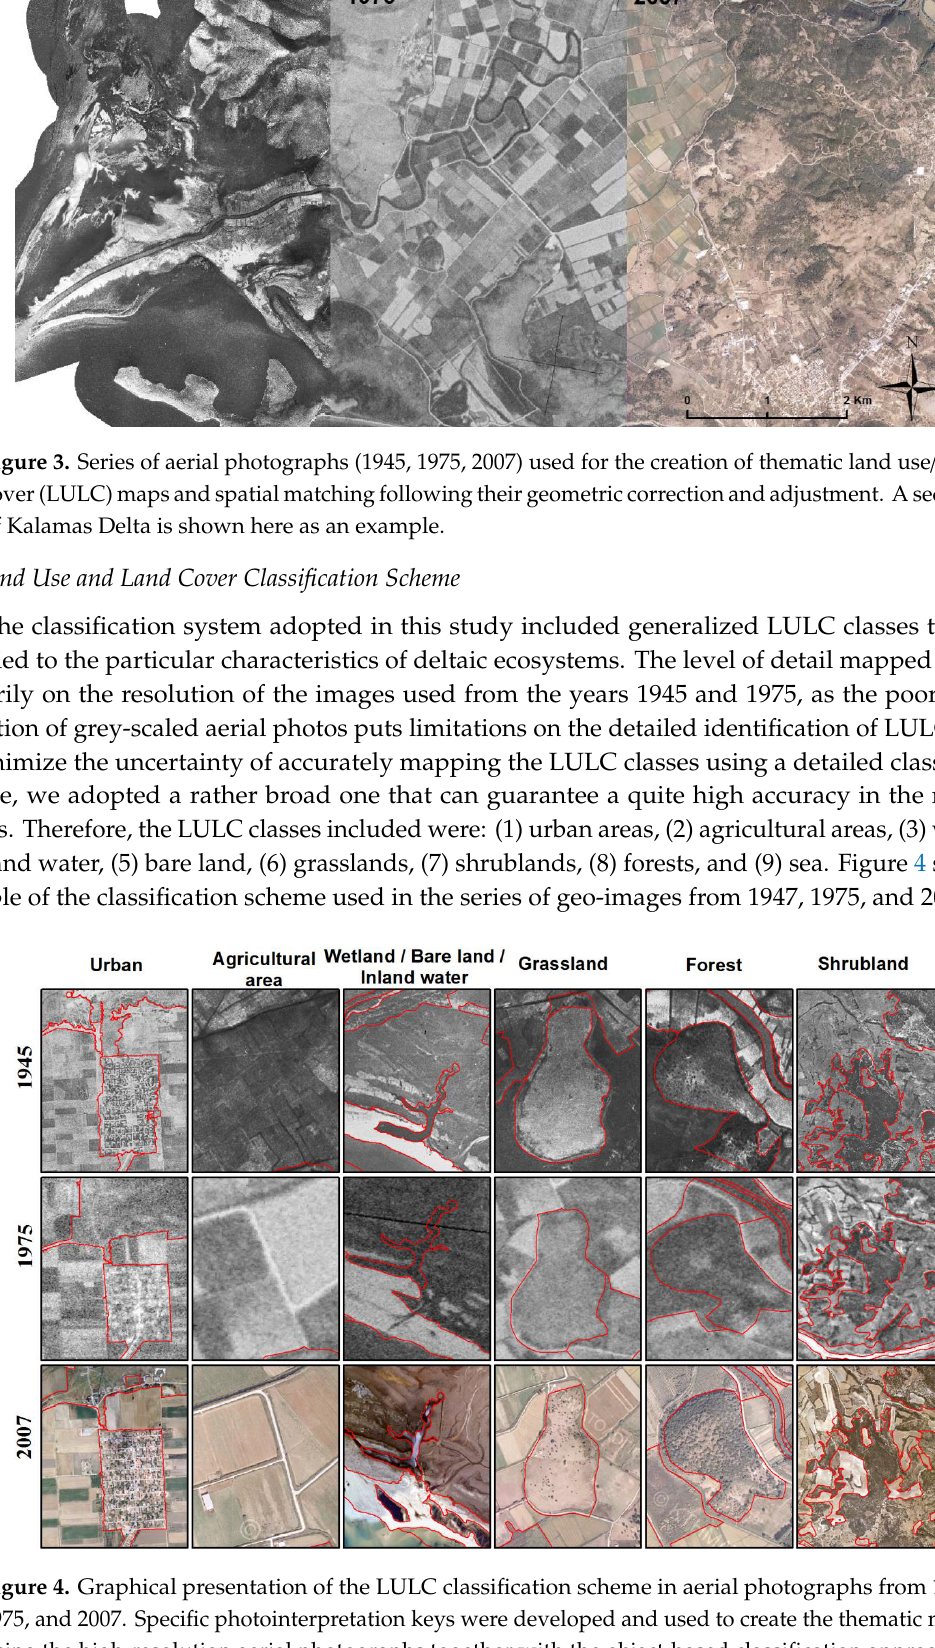
Figure 4. Graphical presentation of the LULC classification scheme in aerial photographs from 1945, 1975, and 2007. Specific photointerpretation keys were developed and used to create the thematic maps using the high-resolution aerial photographs together with the object-based classification approach.